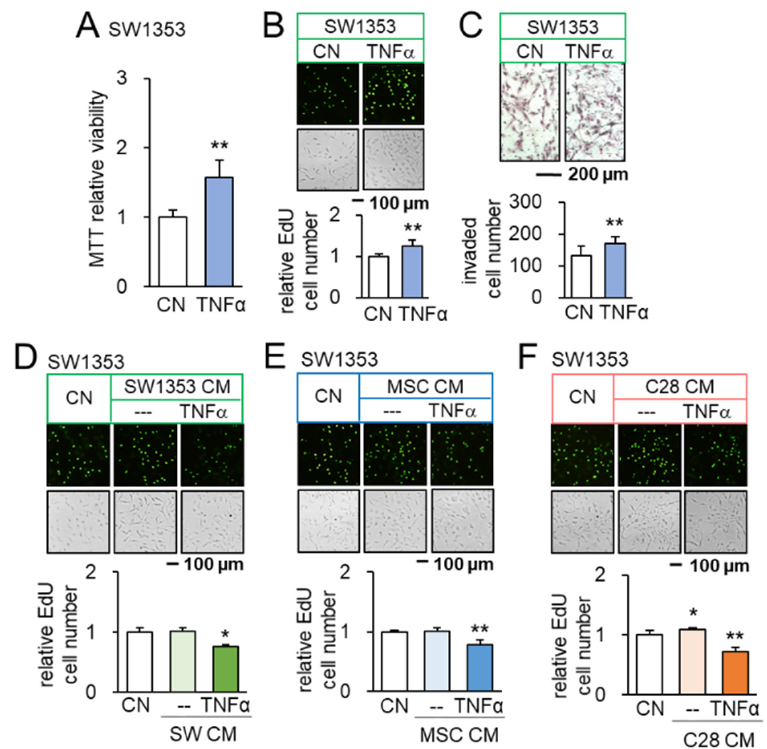
Figure 2. Opposing effects of TNF α and TNF α -treated CM on SW1353 CS cells. CN = control, CM = conditioned medium, and C28 = C28/I2 chondrocytes. The single and double asterisks indicate p < 0.05 and 0.01, respectively. ( A – C ) Increase in MTT-based viability, EdU-based proliferation, and transwell invasion of SW1353 cells in response to 10 ng/mL of TNF α ( n = 6). ( D ) Upregulation of Runx2 and Snail in SW1353 cells by 10 ng/mL of TNF α ( n = 6). ( E , F ) Reduction in EdU-based proliferation of SW1353 cells by TNF α -treated CS cells, MSC, and C28 chondrocyte-derived CMs, respectively ( n = 6). The concentration of TNF α was 10